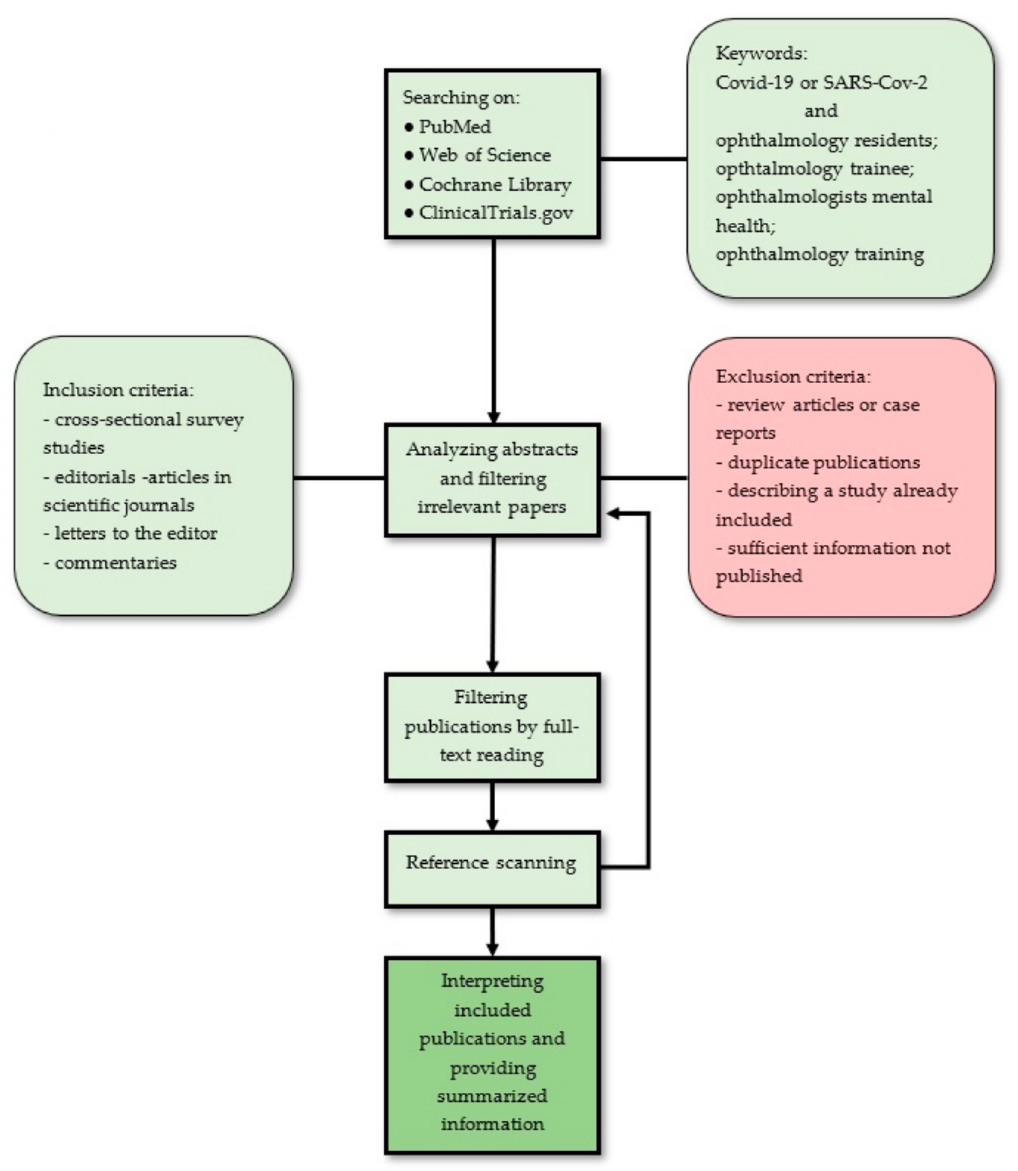
Figure 3. Flow graph illustrating proposed